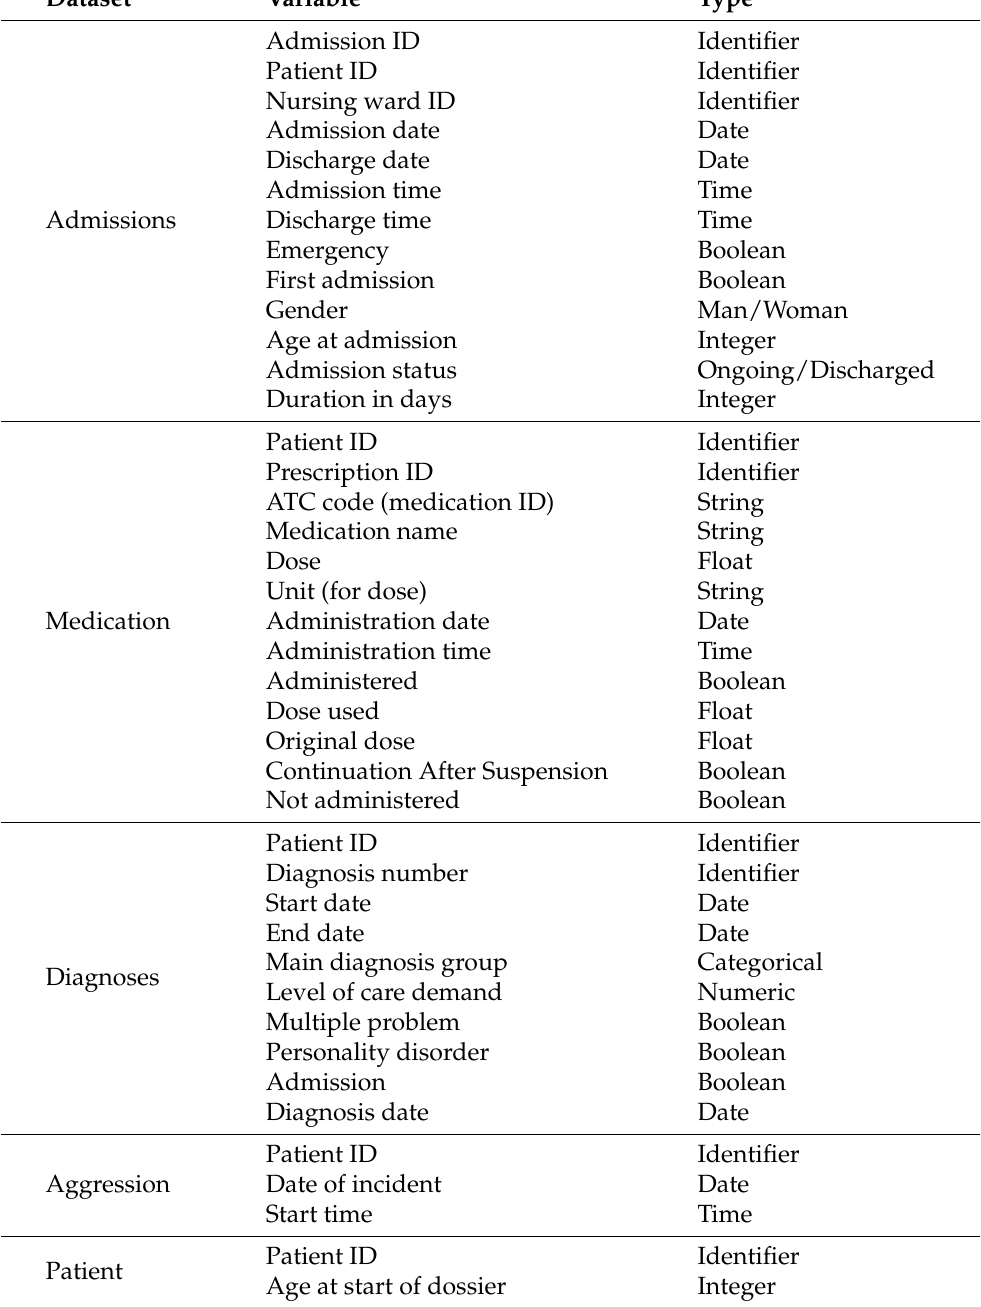
Table 1. Datasets retrieved from the psychiatry department of the UMC Utrecht, with the variables present in each dataset that are used for this study. Psychiatry is divided into four nursing wards . For the “medication” dataset, the “Administered” and “Not administered” variables contain, in principle, the same information; however, sometimes only one of them is